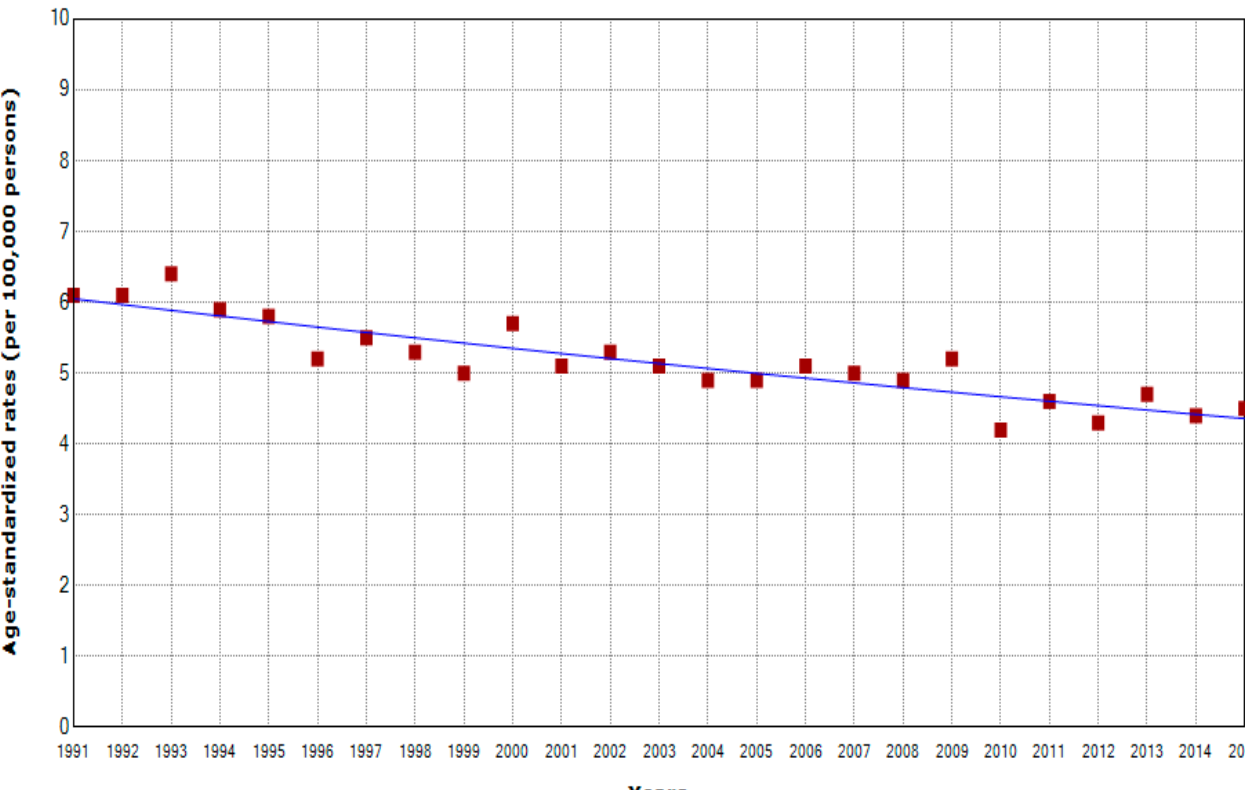
Figure 1. Joinpoint regression analysis of liver cancer mortality in Serbia, 1991–2015: All 0 Joinpoints. Legend: ˆ Statistically significant trend; APC, Average Percentage Change.